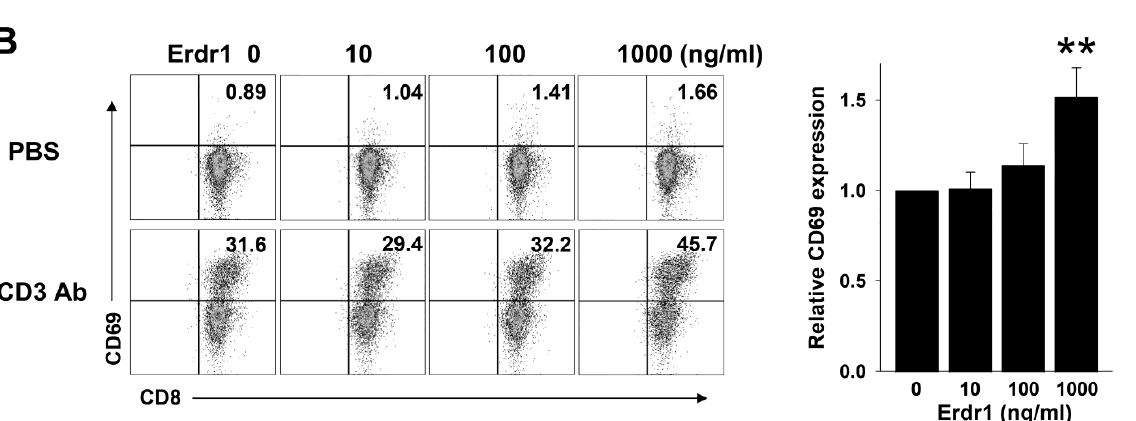
Figure 1. Erdr1 enhances the expression of CD69 in T cells in the presence of TCR stimulation.CD4 T and CD8 T cells were isolated from peripheral lymph nodes of mice and cultivated with the indicated concentrations of Erdr1 in the presence of TCR stimulation for 18 h. ( A ) CD4 T cells were cultured in anti-CD3 ε antibody-coated plates (125 ng/mL), and CD69 + cells were evaluated by flow cytometry. Results with TCR stimulation were summarized as relative levels of CD69 expression (mean ± SD). ( B ) CD8 T cells were cultured as the same method of the CD4 T cell incubation except 250 ng/mL of anti-CD3 antibody was coated. The expression of CD69 was also examined, and relative levels in the presence of TCR stimulation were summarized as mean ± SD. The numbers indicate the percentages of quadrants. The flow cytometric results are representative of data from three independent experiments. * p < 0.05, ** p < 0.01 (vs. Erdr1 0 ng/mL).